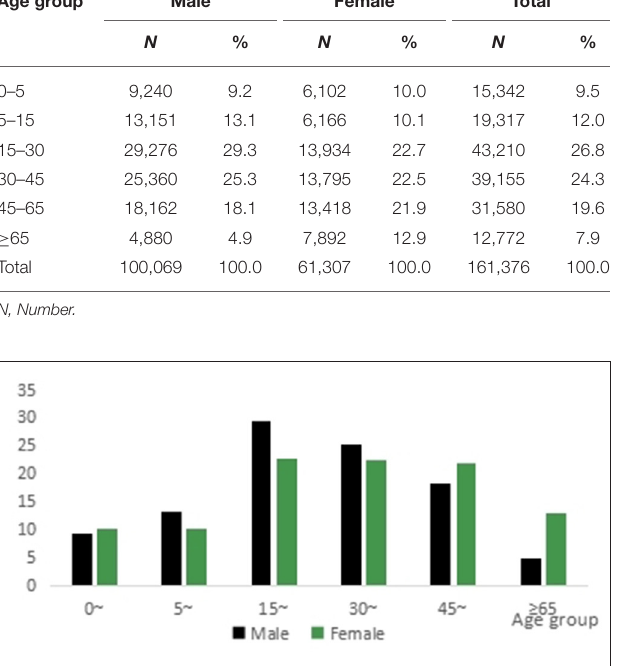
FIGURE 1 | Injury cases by age group and gender.